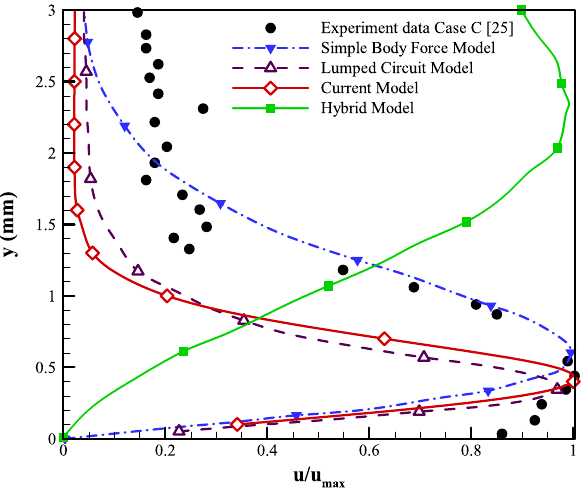
Figure 17. The results from the presented numerical model compared to the experimental and other numerical vertical velocity profiles on actuator geometry of Case C.